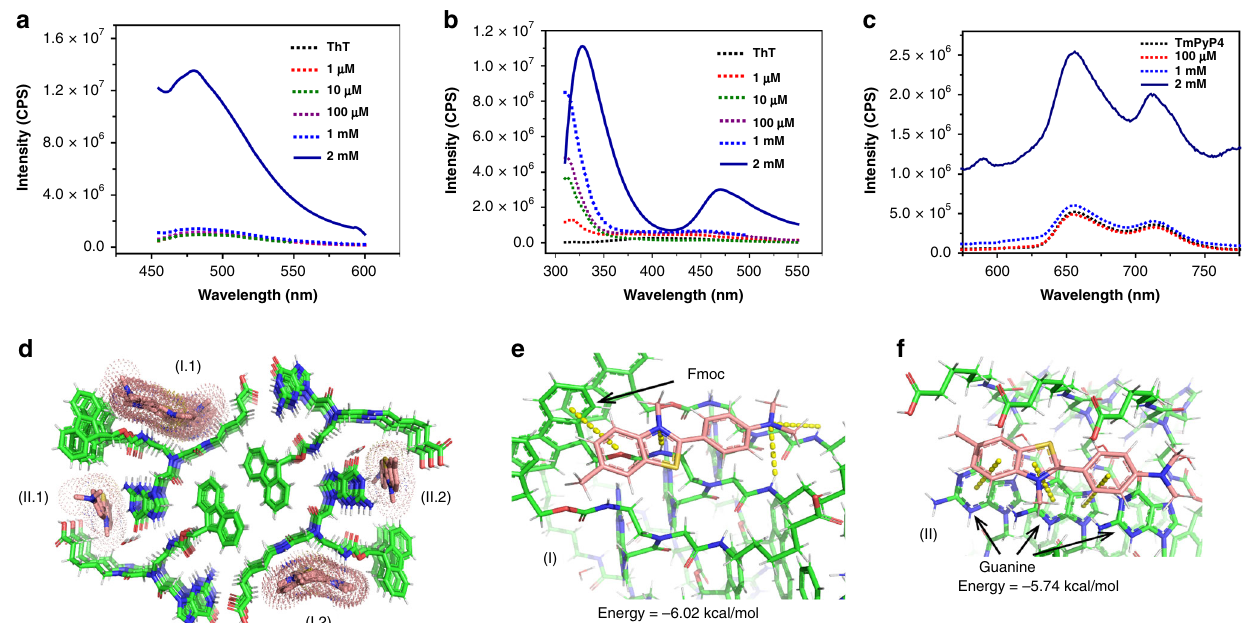
Fig. 4 ThT/TmPyP4 binding to Fmoc-G-PNA tetramer. a Fluorescence emission spectra of 20 μ M ThT with various concentrations of the Fmoc-G-PNA conjugate, λ ex = 440 nm. b Fluorescence emission spectra of the Fmoc-G-PNA tetramer in the presence of 20 µ M ThT, λ ex = 290 nm. c Fluorescence emission spectra of 10 μ M TmPyP4 with various concentrations of the Fmoc-G-PNA conjugate, λ ex = 433 nm. d – f Molecular docking of ThT to the Fmoc- G-PNA tetramer. d Binding sites of the fi rst 30 energy-optimized docking patterns. The conformations are clustered into two groups: I.1 and I.2 are equivalent due to the crystal symmetry, as are II.1 and II.2. e , f Interactions mediating the molecule binding in e the fi rst and f the second conformation